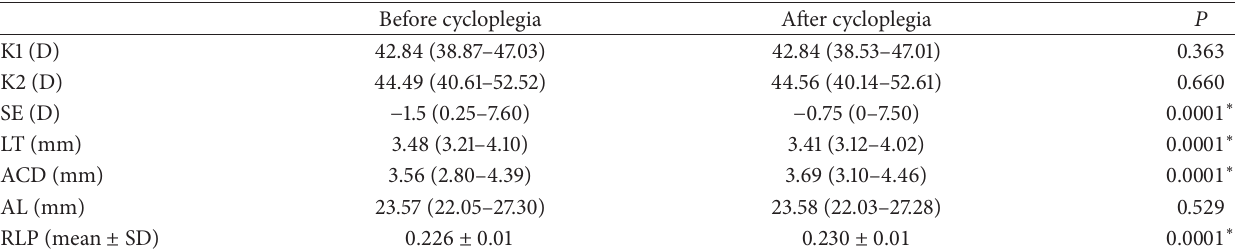
Table 2: Response to cycloplegia in Group 2 ( 𝑛 = 52 ).